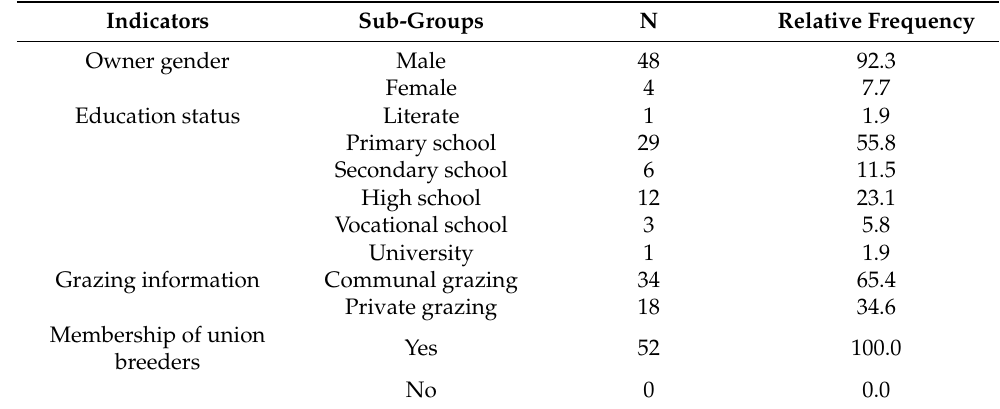
Table 2. Qualitative structural and management characteristics of the buffalo farms in the Marmara Region of